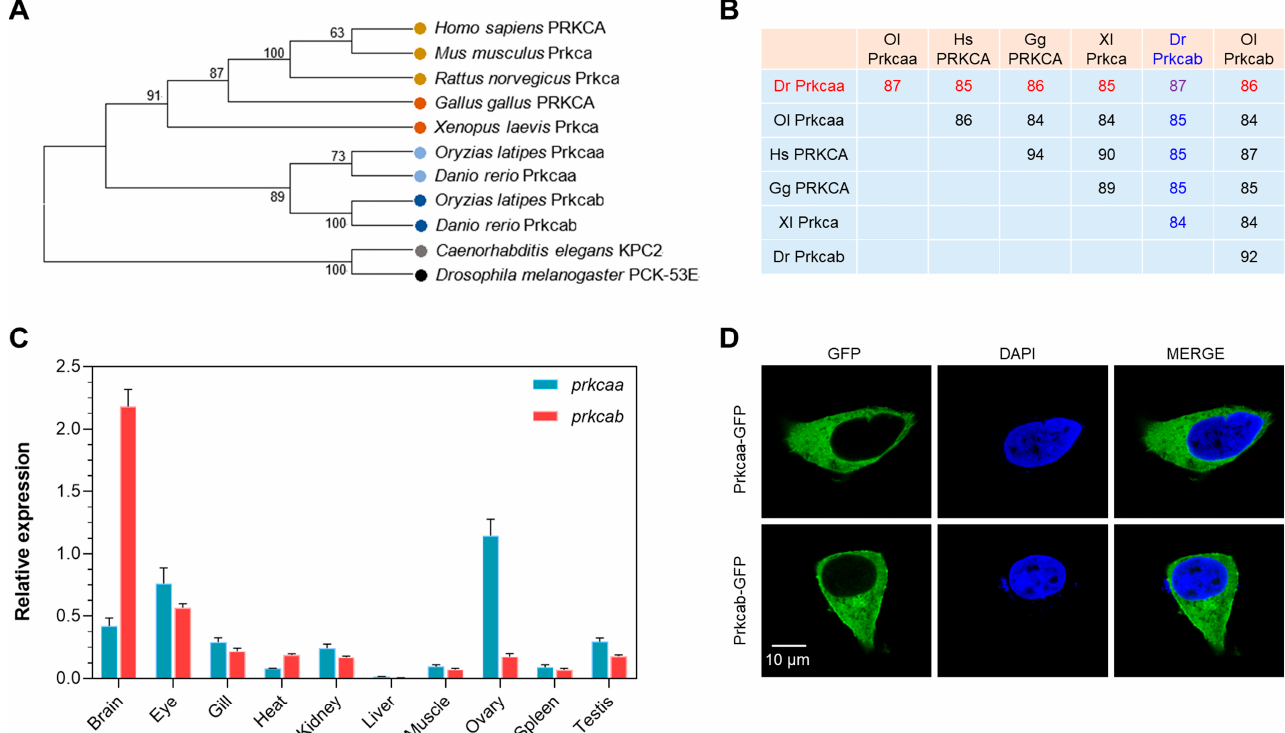
Figure 1. Molecular characterization of zebrafish Prkcaa and Prkcab. ( A ) A phylogenetic tree for PRKCA (or Prkcaa and Prkcab). The sequence accession numbers are listed in Table S1. ( B ) Amino acid sequence identity between PRKCA (or Prkcaa and Prkcab). Dr, Danio rerio ; Gg, Gallus gallus ; Hs, Homo sapiens ; Ol, Oryzias latipes ; Xl, Xenopus laevis . Sequence identities between Dr Prkcaa and the others are shown in red, and those for Dr Prkcab are shown in blue. ( C ) Tissue expression patterns of zebrafish prkcaa and prkcab . The y -axis represents the expression of prkcaa and prkcab normalized to that of 18s rRNA . The error bar stands for standard deviation of 3 technical replicates. ( D ) Subcellular localization of zebrafish Prkcaa and Prkcab expressed in the HEK293T cells.